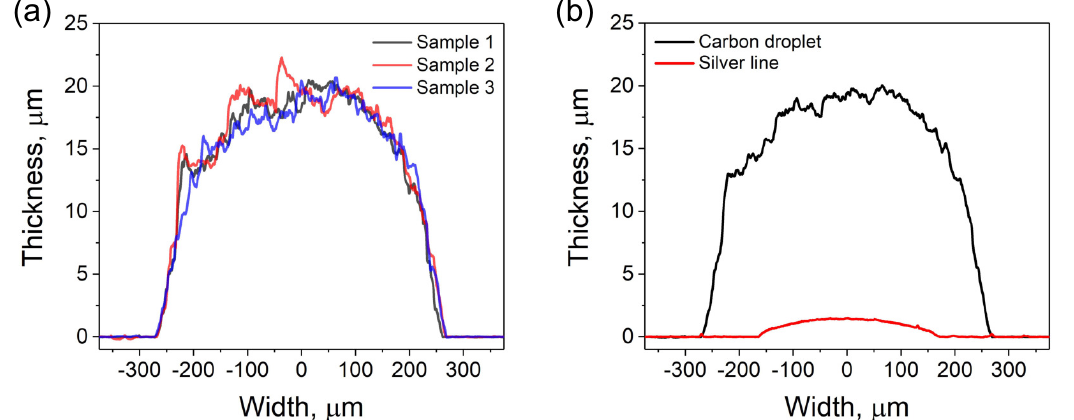
Figure 5. Thickness profile analysis using a mechanical profilometer. ( a ) Comparative analysis of three dried droplets of the carbon ink. ( b ) Average profiles showing the difference between the dimensions of carbon droplets and silver